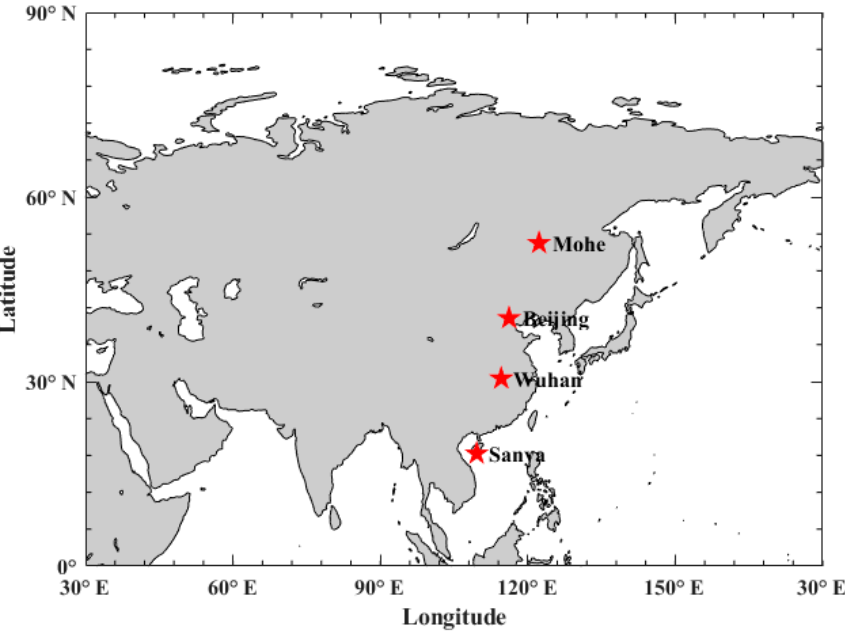
Figure 1. Geographical distribution of Mohe, Beijing, Wuhan, and Sanya meteor radar stations. HWM14 is the newest version for HWM series which has updated in the thermo- sphere with new measurements and formulation changes. The HWM14 provides average horizontal winds as a function of day of year τ , solar local time δ , colatitude θ , longitude φ , and altitude z from the ground to the exobase. A height-modulated vector spherical harmonic basis function (1) is used to present the atmosphere’s dominant recurring cyclical climatological variations.